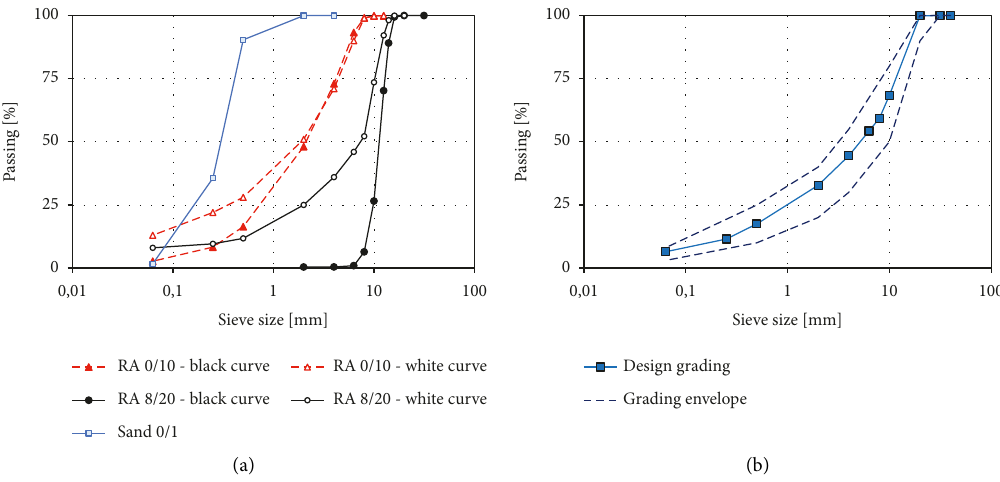
Figure 3: Grading distributions: (a) aggregate fractions; (b) design grading.